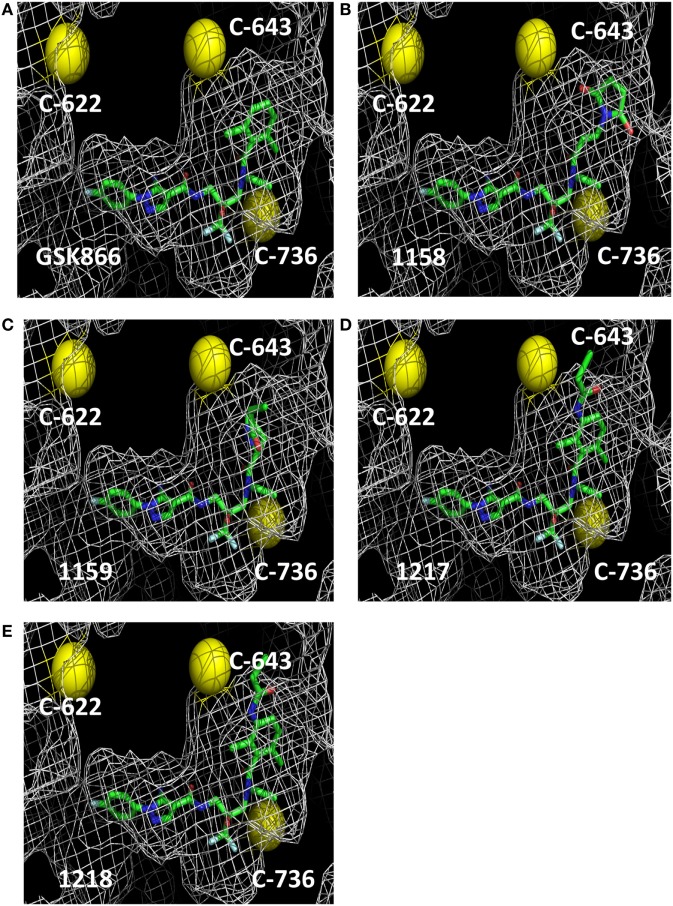
Molecular 3D modeling of cysteine reactive GSK866 analogs UAMC-1158, UAMC-1159, UAMC-1217, and UAMC-1218. Molecular 3D modeling of SEGRA GSK866 (A) and synthetic analogs UAMC-1158 (B), UAMC-1159 (C), UAMC-1217 (D), and UAMC-1218 (E) in the glucocorticoid receptor ligand-binding domain crystal structure 3E7C. Proximal cysteine residues C622, C643, and C736 are represented as yellow balls.